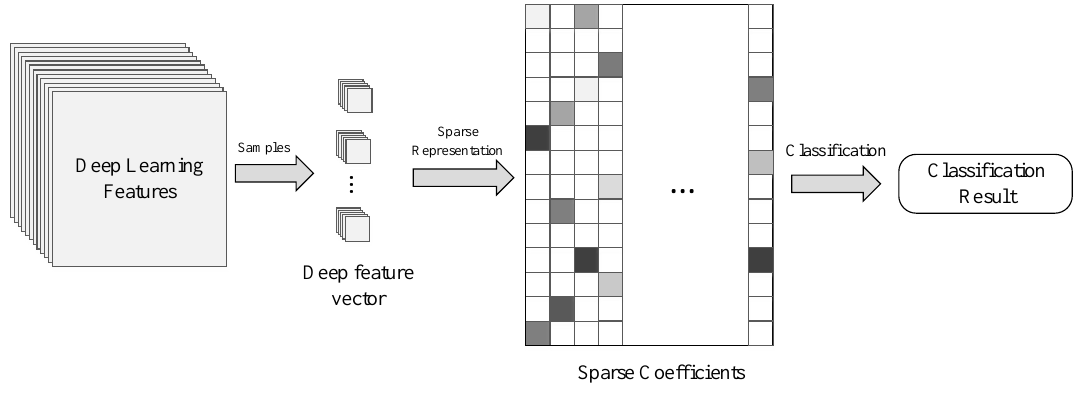
Figure 3. The process of deep feature-based sparse representation